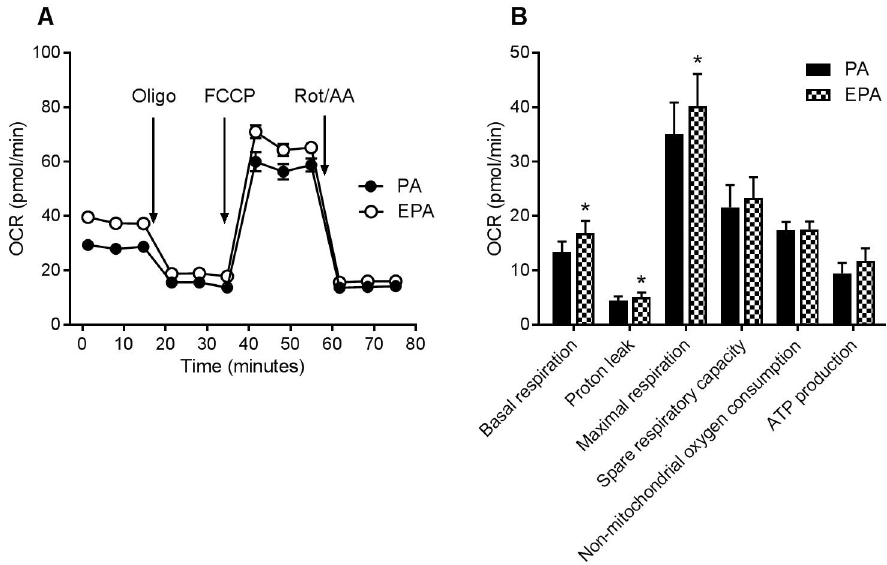
Fig 4. Mitochondrial function after preincubation with fatty acids. Human skeletal muscle cells were grown in 96-well Seahorse tissue culture plates, and treated with 100 μ M of PA or EPA for 24 h, before measurement of oxygen consumption rate (OCR) with the Seahorse XF96e analyzer. (A) OCR time curve from an experiment with one of two donors. (B) OCR parameter calculations by the Seahorse XF Mito Stress Test Report Generator from experiments with two different donors (n = 8). Results represent mean ± SEM. � p < 0.05 for EPA vs. PA (t-test). EPA, eicosapentaenoic acid; PA, palmitic acid; Oligo, oligomycin; FCCP, carbonyl cyanide-p-trifluoromethoxyphenylhydrazone; Rot, rotenone, AA, antimycin